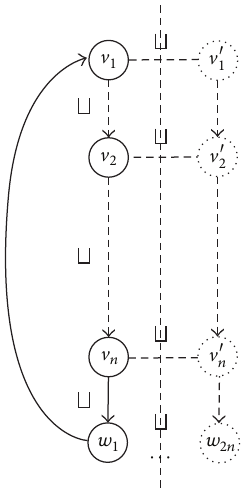
Figure 1: Runing the search using